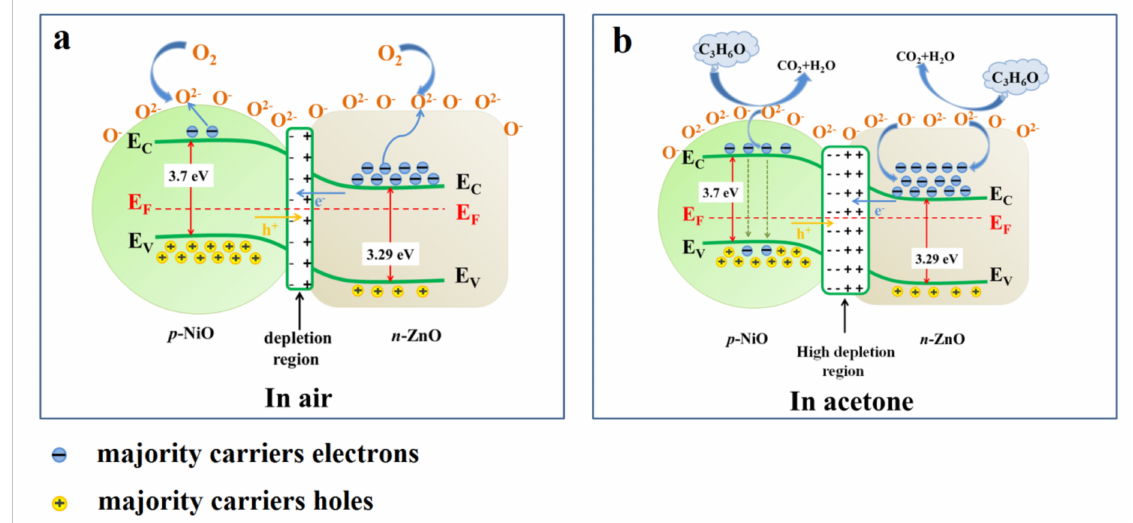
Figure 5. ( a ) Band diagram for ZnO / NiO interface in air, ( b ) band diagram for ZnO / NiO after interface in target